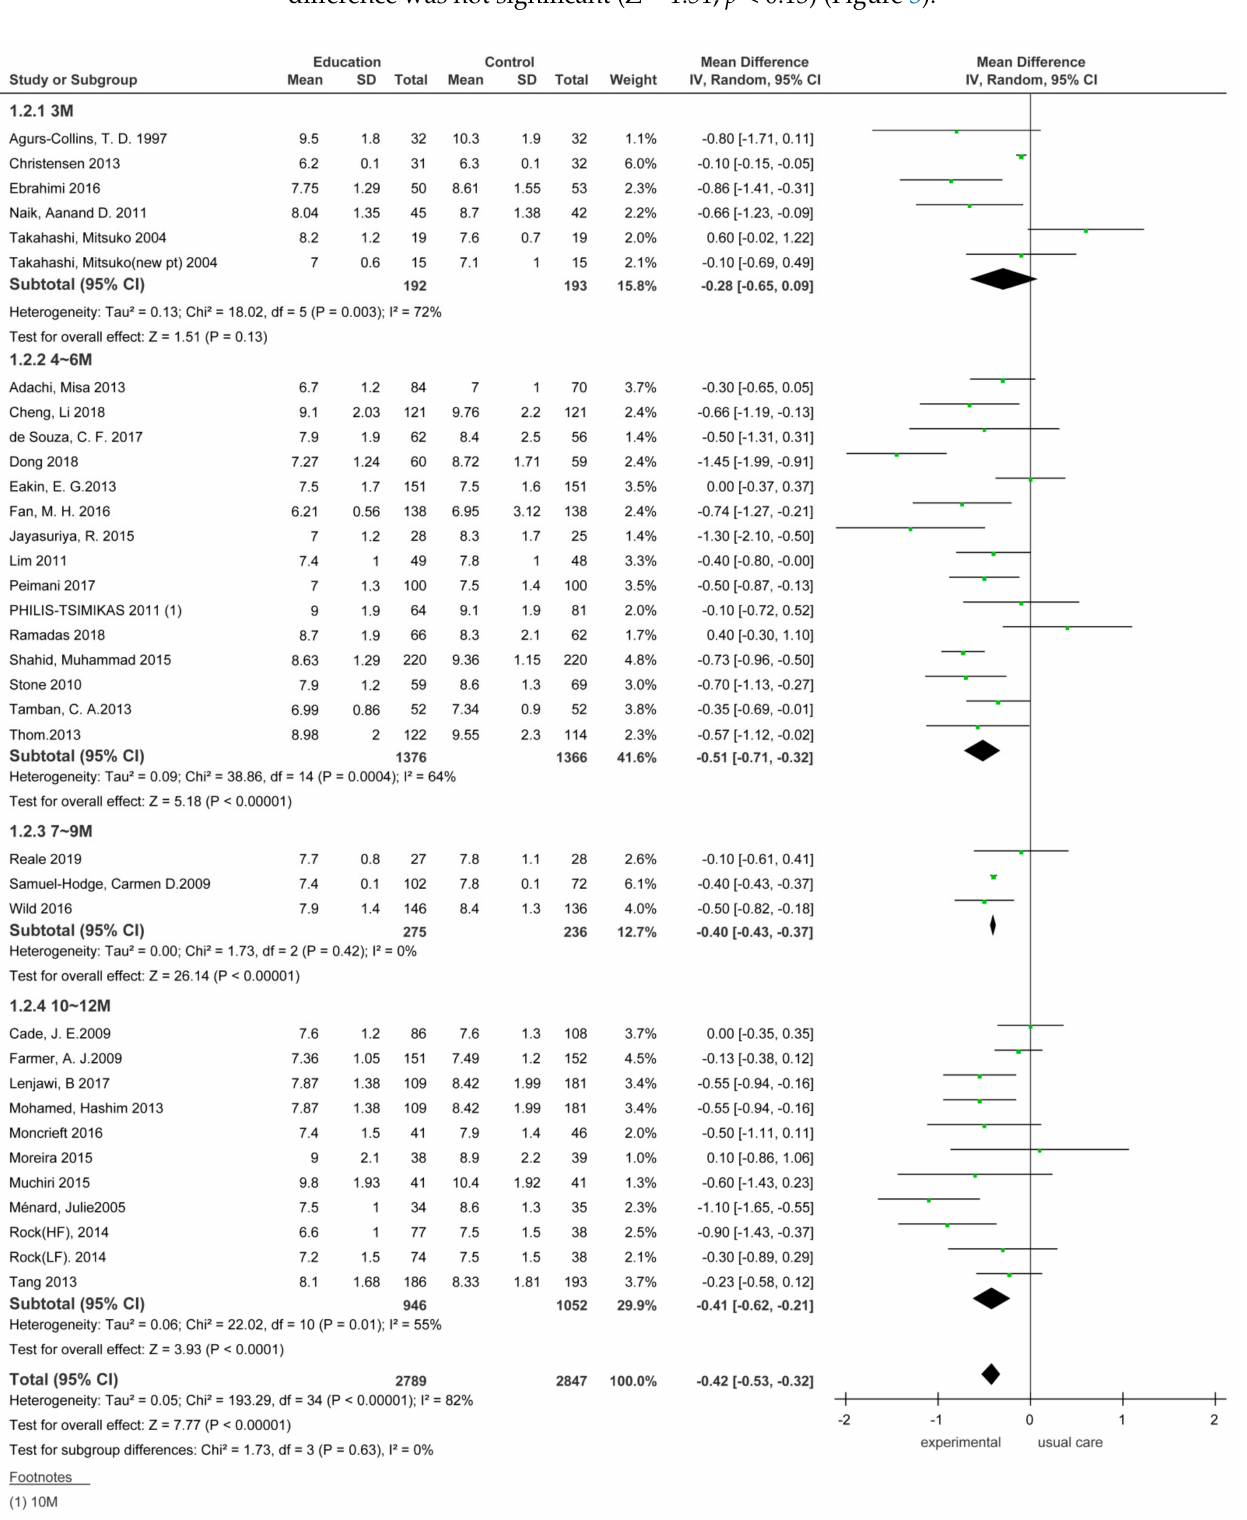
Figure 3. Immediate effect of dietary education intervention on patients with type 2 diabetes. SD, standard deviation; CI, confidence interval; IV, inverse